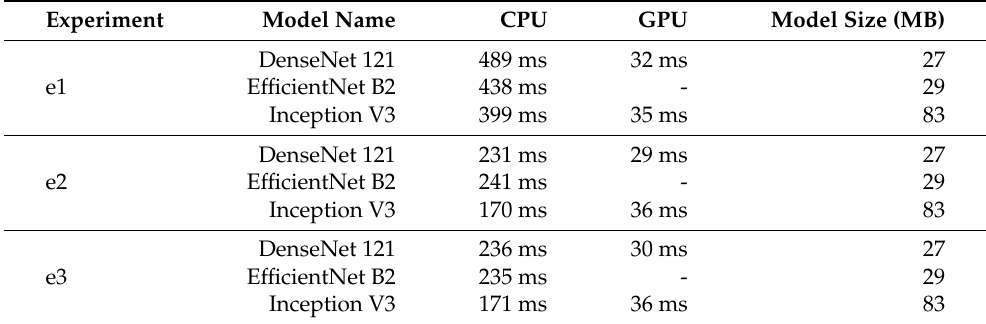
Table 15. The performance values below are measured on Android 12 from Google Pixel